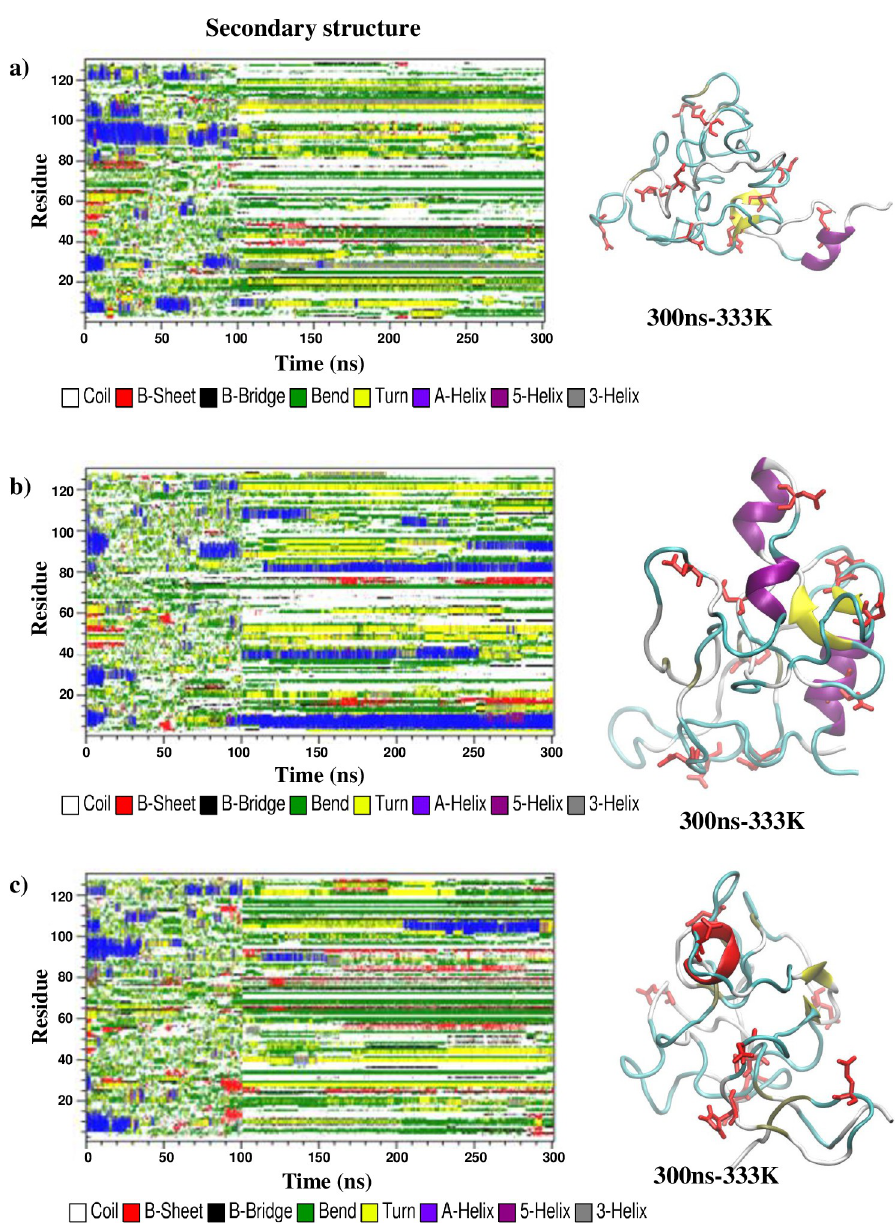
Fig 3. Time evolution of the secondary structures contents determined by the DSSP algorithm along the 450-K and 333-K simulation replicas (a) R0, (b) R1, and (c) R2 at pH 7. Snapshots of the final structure after the 333 K simulation was also given for each